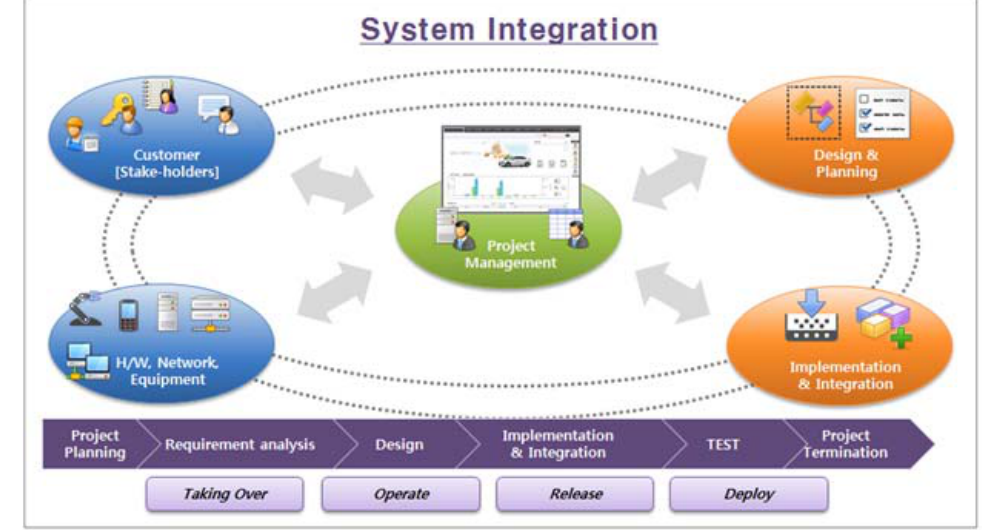
Figure 6. An SI project management plan.